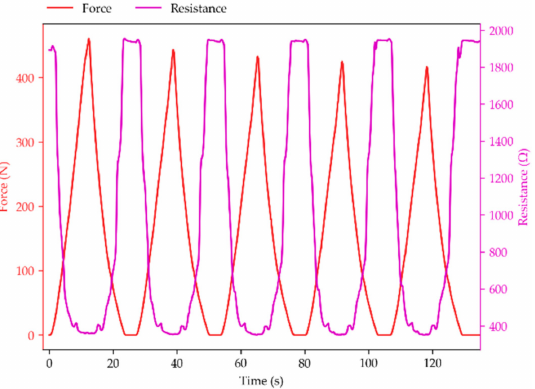
Figure 4. Force and resistance plots for the measurement with the highest standard deviation: variant 4 (Figure 1e), gap of 0.3 mm at 10 mm/min velocity. A decrease in peak force is visible with repeated actuation.